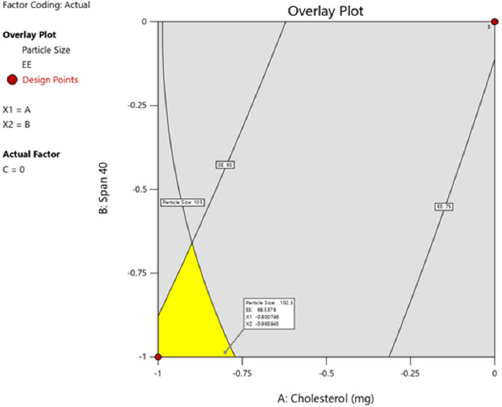
Figure 3. Software-generated overlay plot for the selection of the best batch from design space. Particle Size and Zeta Potential of Optimized Batch